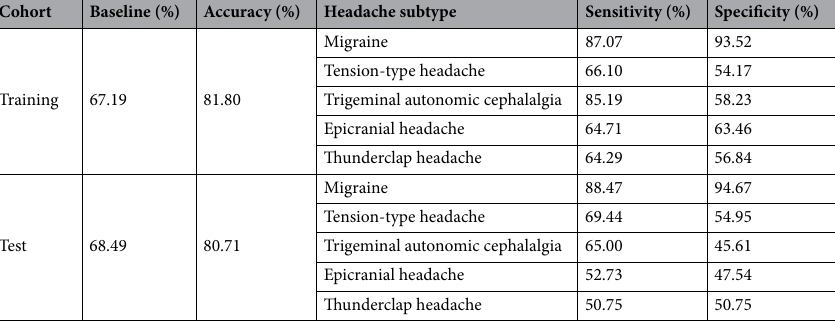
Table 3. Classifier performance of both